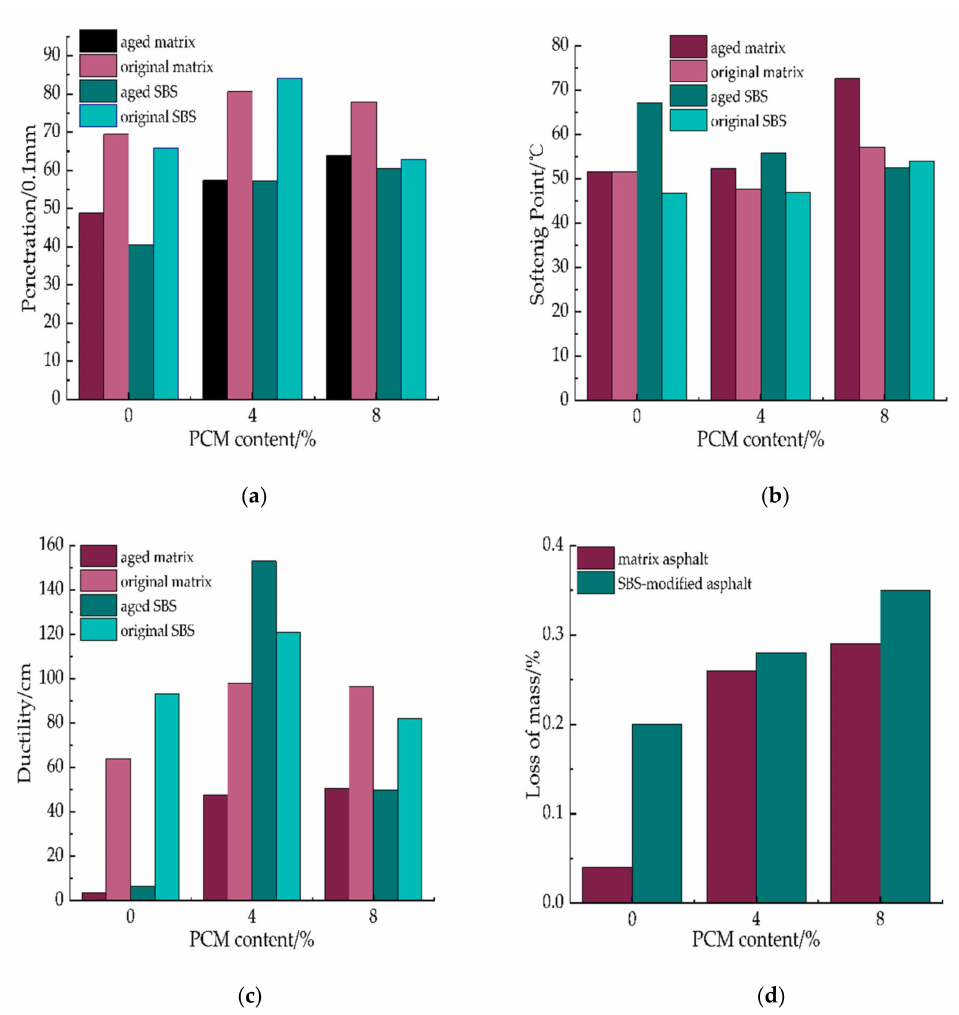
Figure 2. Physical property test results of asphalt samples before and after PAV aging. ( a ) penetration test results; ( b ) softening point test results; ( c ) ductility test results; ( d ) loss of mass test